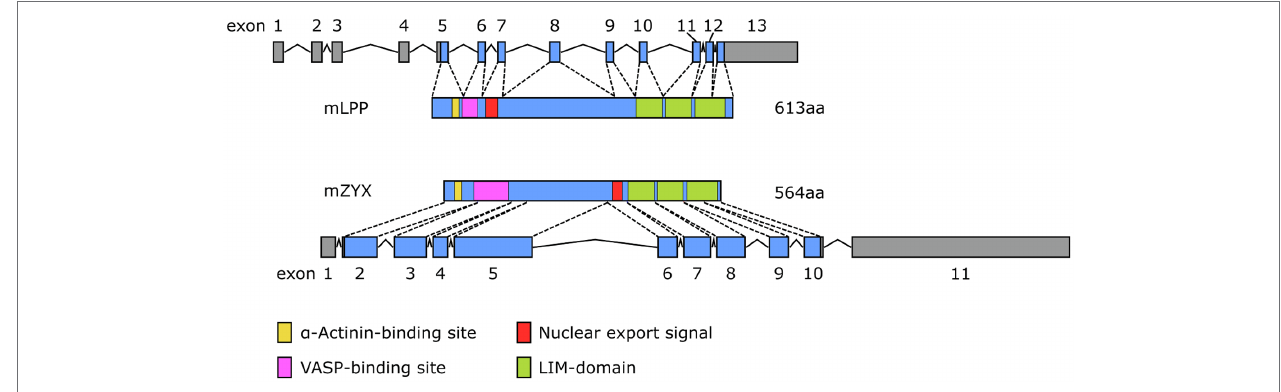
FIGURE 4 | Comparison of the exon-intron structure of the primary transcripts (hnRNA) of the murine (top) Lpp and (bottom) Zyx gene and their corresponding protein products (mLPP, mZYX). The color coding for the functional elements in both proteins corresponds to that of Figure 2 .